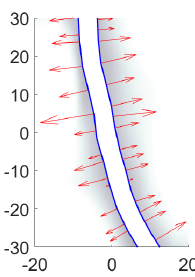
Fig. 5. Experiment 1 (Cell-cell collision) In a close-up we visualize the repulsive collision forces in action. The magnitude of the forces increases rapidly when the cells come in proximity (closer than a user-defined threshold). When the forces become too large, the polymerizaiton of the corresponding filaments